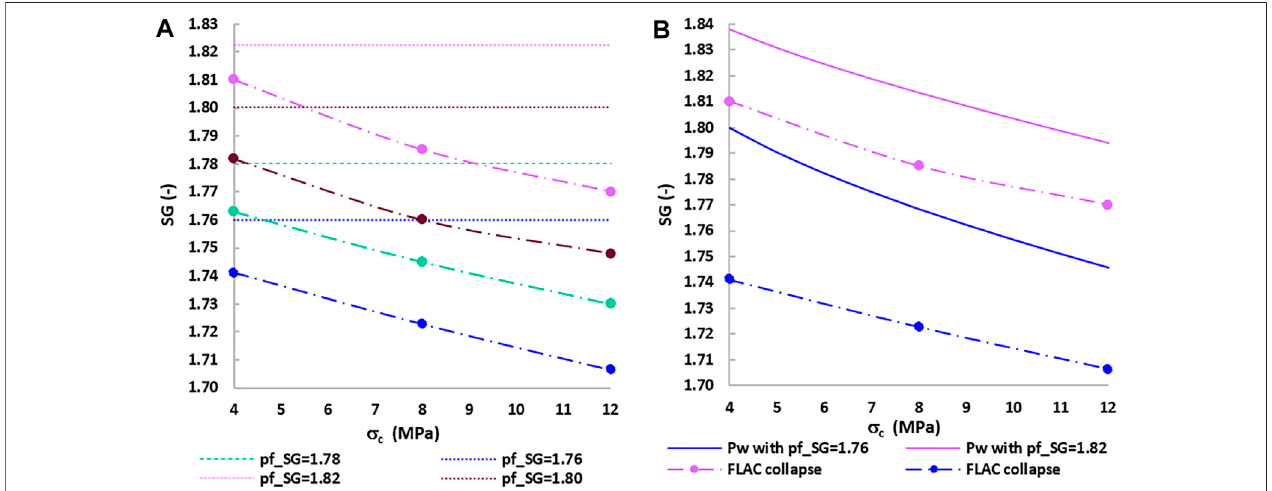
FIGURE 13 | (A) Comparison between the mud weight of borehole collapse calculated with FLAC at different overpressures p f _ SG = 1.76 – 1.82 and the uniaxial compressive strength σ c = 4 – 12 MPa. (B) Comparison between the limit mud weight calculated analytically and the mud weight corresponding to wellbore collapse calculated with